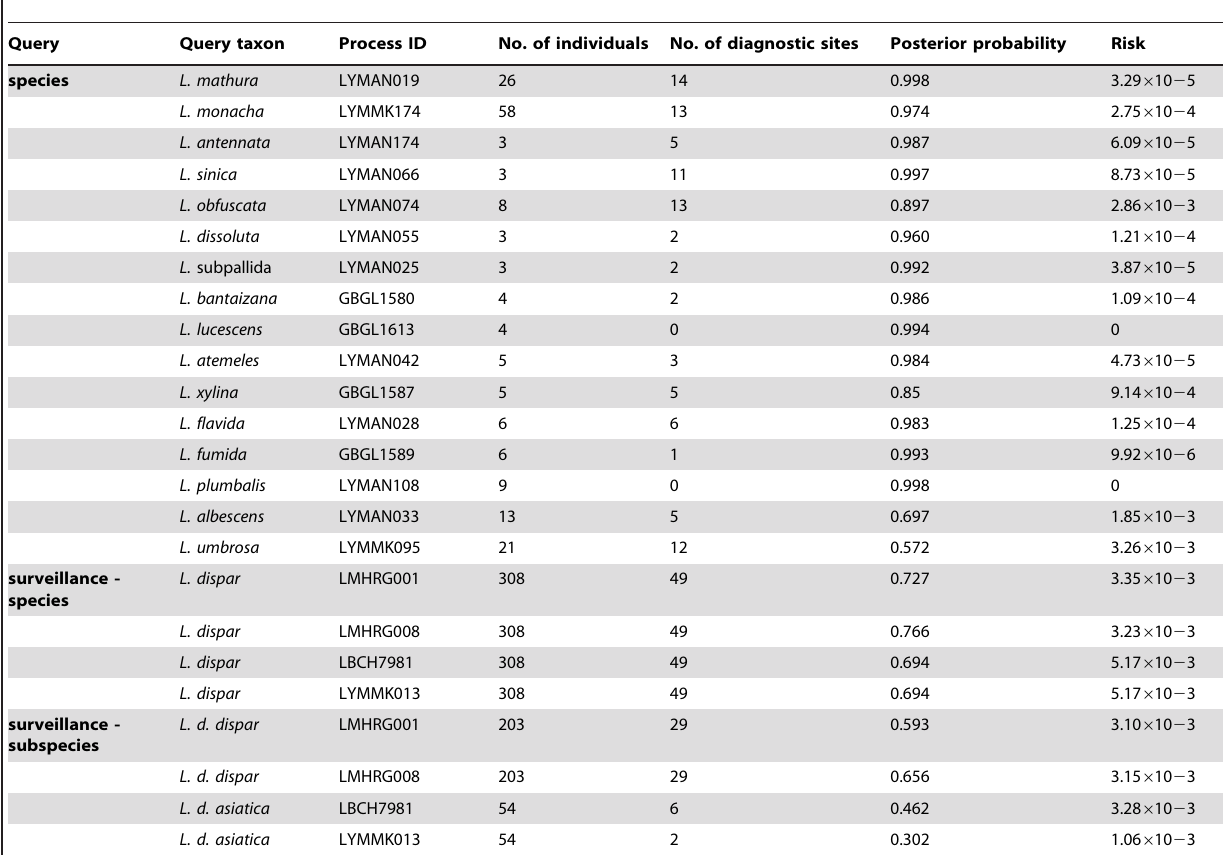
Table 2. Assignment of random and surveillance individuals to species and sub-species.